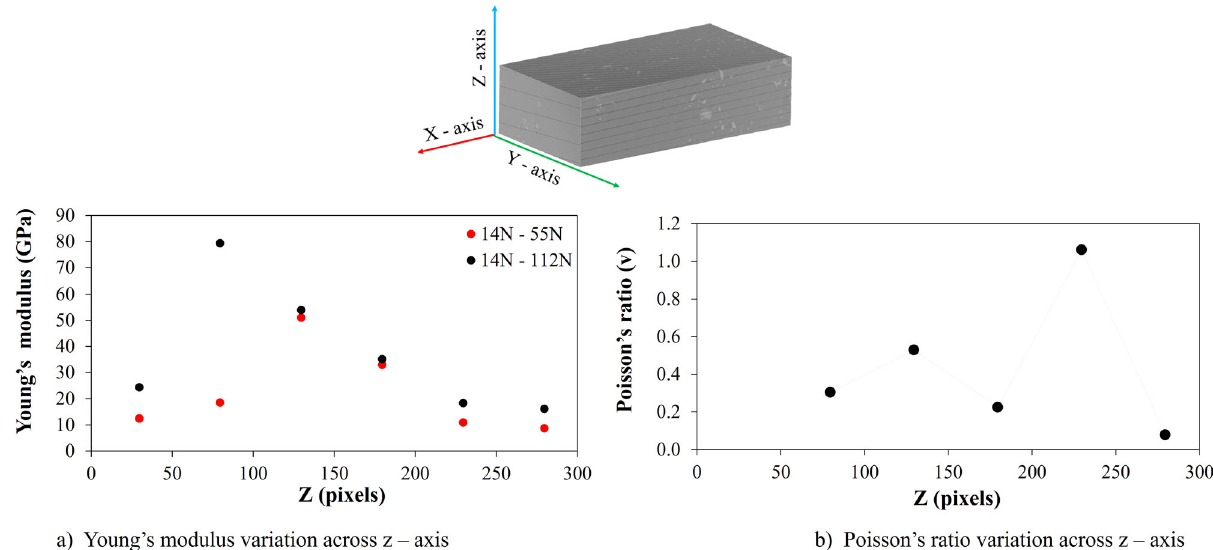
Fig. 9 Variation in MCCI-simulant mechanical properties across the height of the DVC-inspected volume based on calculated mean XY planar vertical strains. a Young ’ s modulus. b Poisson ’ s